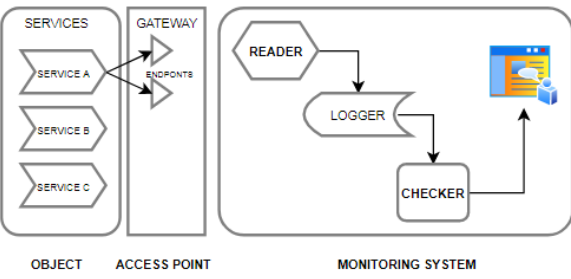
Figure 5. Framework for Monitoring Microservices